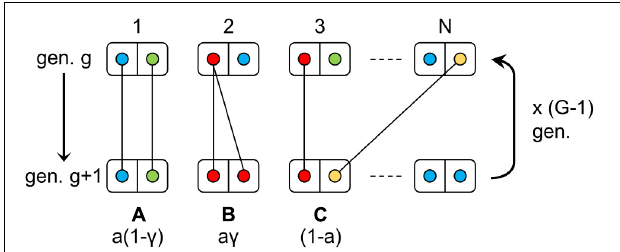
FIGURE 1 | Design of the model simulated. Each box represents a diploid individual with circles of different colors corresponding to distinct alleles of a same locus. The letters A, B, and C represent the possible inheritance modes and their corresponding probability: A = automixis without loss of heterozygosity, B = automixis with loss of heterozygosity and C = sexual reproduction. The letters a and γ denote the rates of automixis and loss of heterozygosity, respectively. This process is repeated G-1 times to generate G new generations. For each transmission event between generations, there is a probability µ that the allele transmitted mutated to a new, non-existing, allele. “gen.” stands for